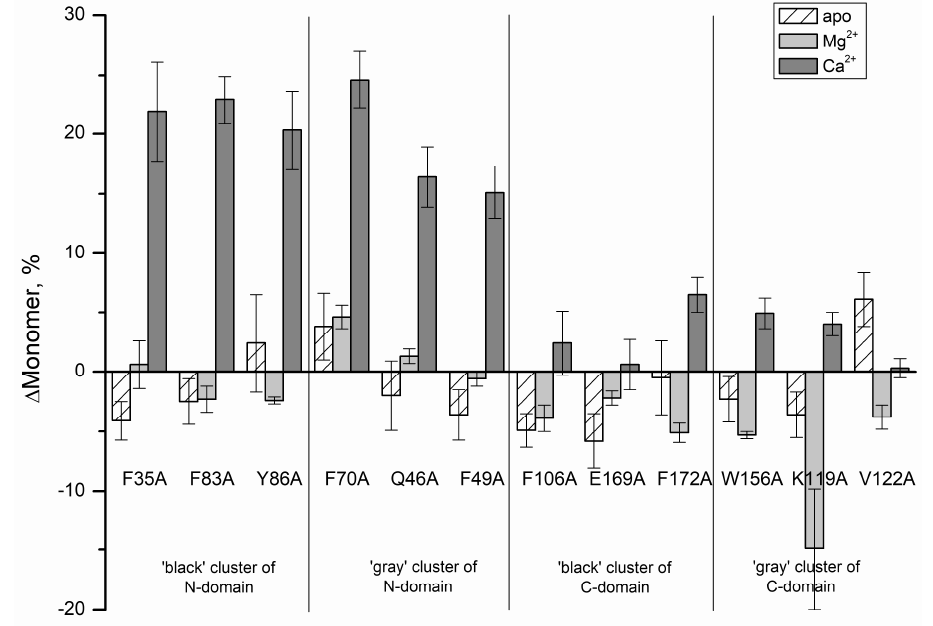
Figure 3. Effects of the alanine cluster mutations on monomer content for various states of recombinant wild type recoverin.